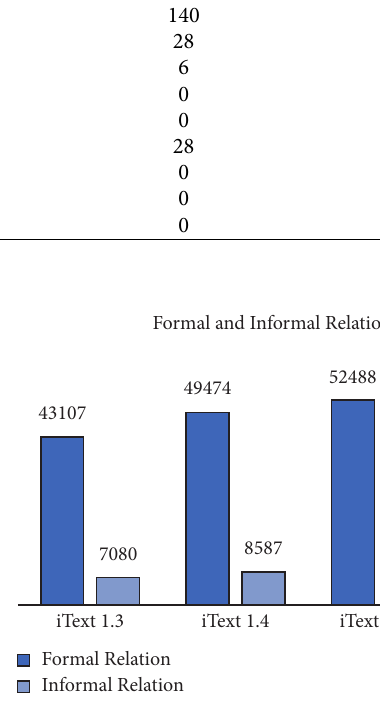
Figure 3: Count of formal and informal relationships in